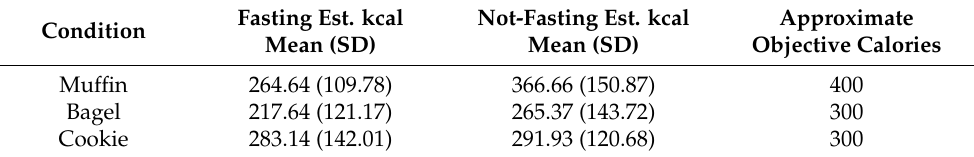
Table 3. Estimated Calories are Lower for fasting (vs. non fasting) condition (N = 65). Fasting Est. kcal Not-Fasting Est. kcal Condition Mean (SD)